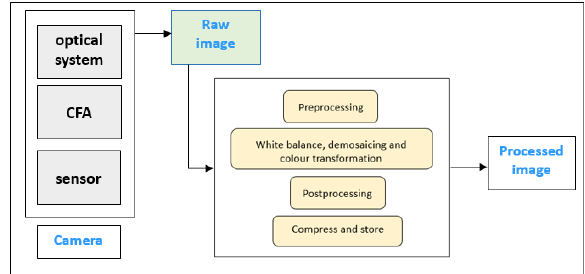
Figure 3. General image processing pipeline